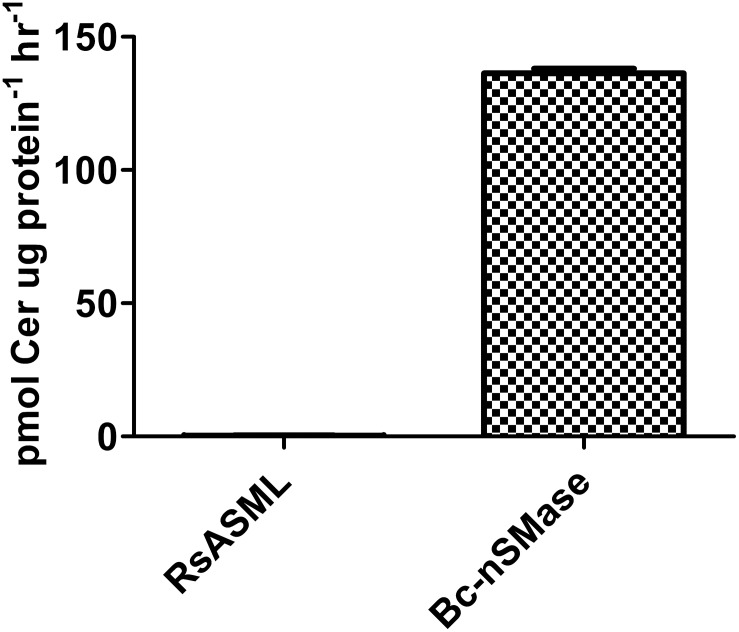
Sphingomyelinase activity of RsASML and Bc-nSMase.RsASML reaction conditions: 10 mM HEPES, pH 8.0, 1 mM NiCl2. Bc-nSMase (Bacillus cereus nSMase) reactions conditions: 10 mM HEPES, pH 7.5, 10 mM MgCl2.